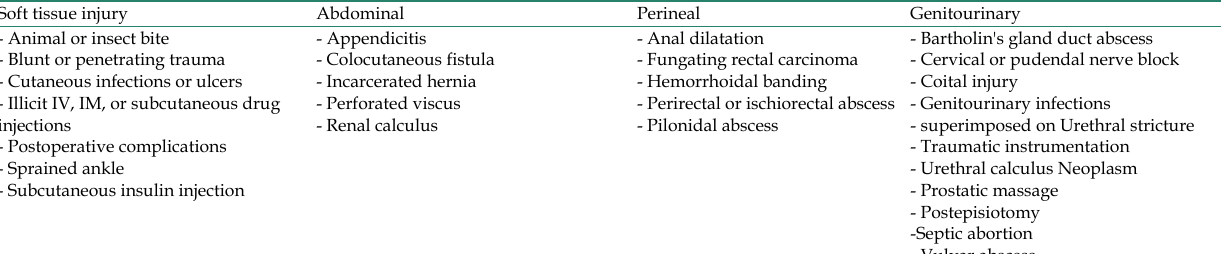
Table 1. Etiology of NF of the lower extremities, abdominal wall and perineum (modified according to Green et al. (1996)).